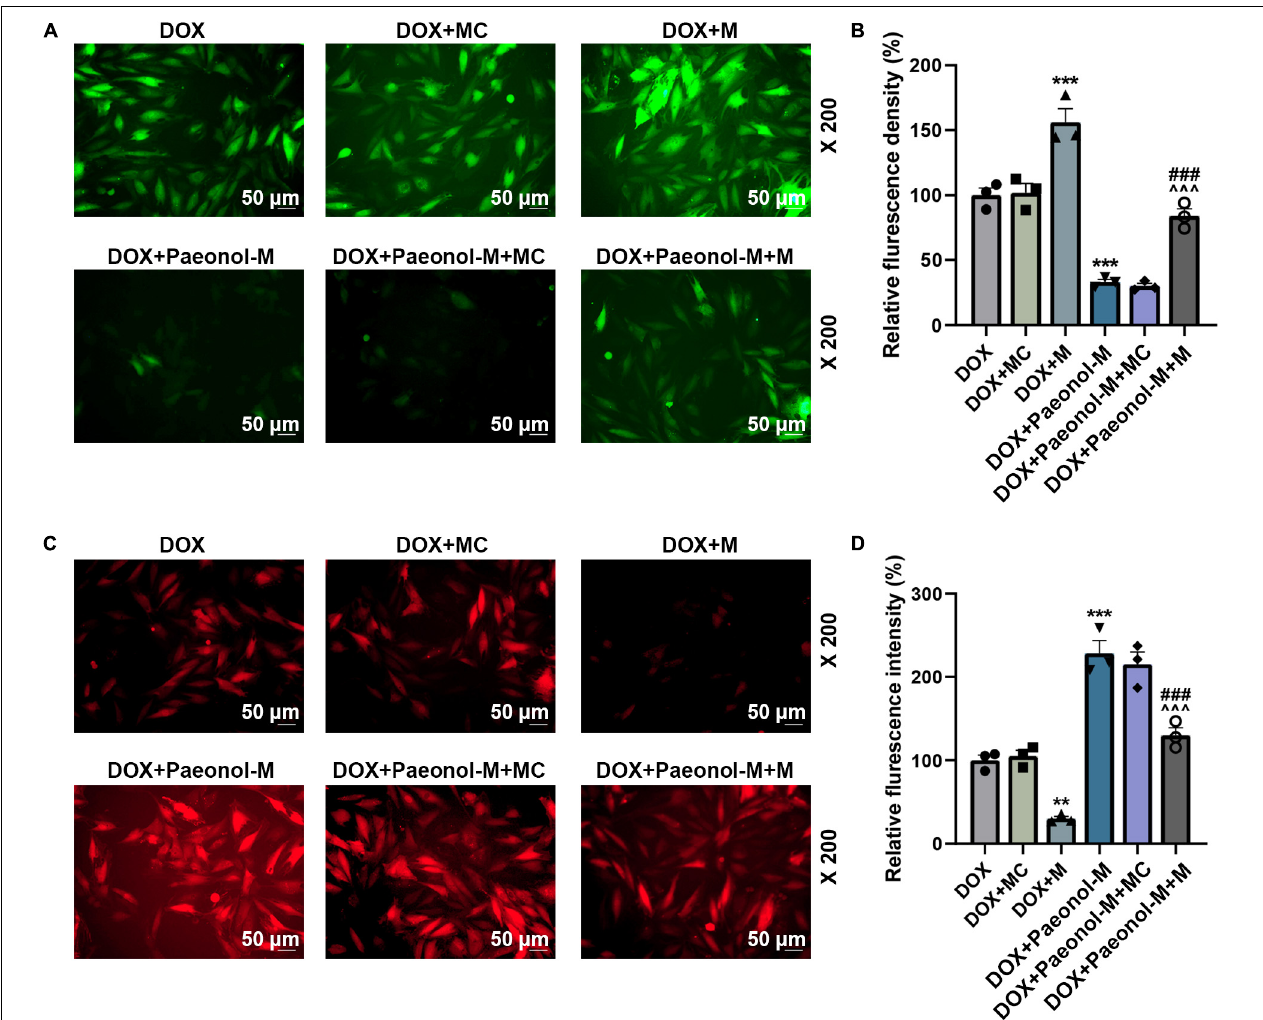
FIGURE 5 | miR-21-5p mimic counteracted the effects of paeonol on the MMP and ROS of the DOX-induced cardiomyocytes. (A,B) The ROS level in the DOX-induced H9c2 cells treated with miR-21-5p mimic or Paeonol-M was observed by H2DCFDA staining. (C,D) The MMP in the DOX-induced H9c2 cells treated with miR-21-5p mimic or Paeonol-M was determined by TMRM staining. ** P < 0.01, *** P < 0.001 vs. DOX + MC; ### P < 0.001, vs. DOX + M; ∧∧∧ P < 0.001 vs. DOX + Paeonol-M + MC. DOX, doxorubicin; MMP, mitochondrial membrane potential; ROS, reactive oxygen species; M, miR-21-5p mimic; MC, mimic control.